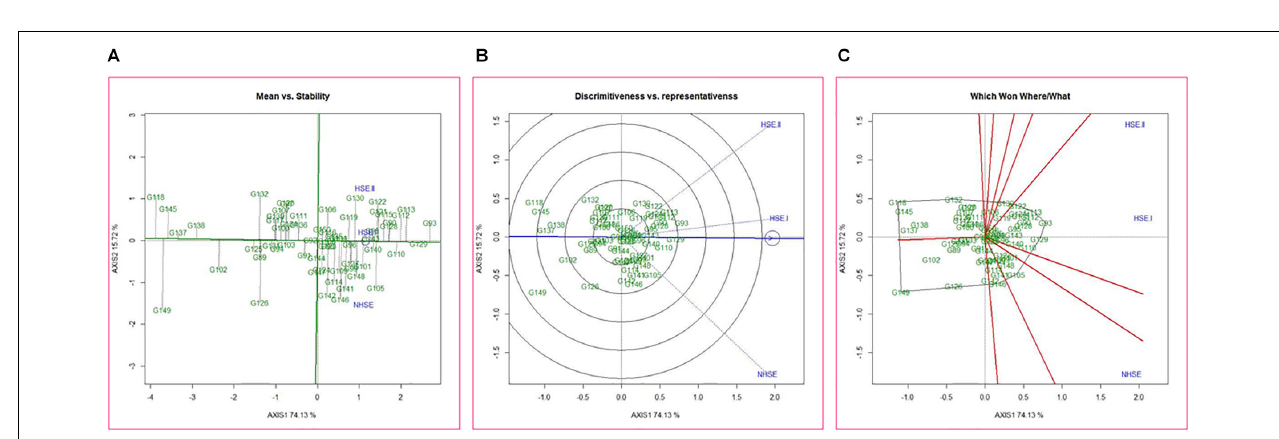
FIGURE 5 | GGE biplots developed by plotting the first and second principal components derived from the germination value of early-maturing genotypes of field pea evaluated in three environments (NHSE, HSE-I, and HSE-II). (A) “Mean versus Stability” view of genotypes. (B) Discriminating ability and representativeness of three environments, (C) which won where/what of field pea genotypes under different environments.